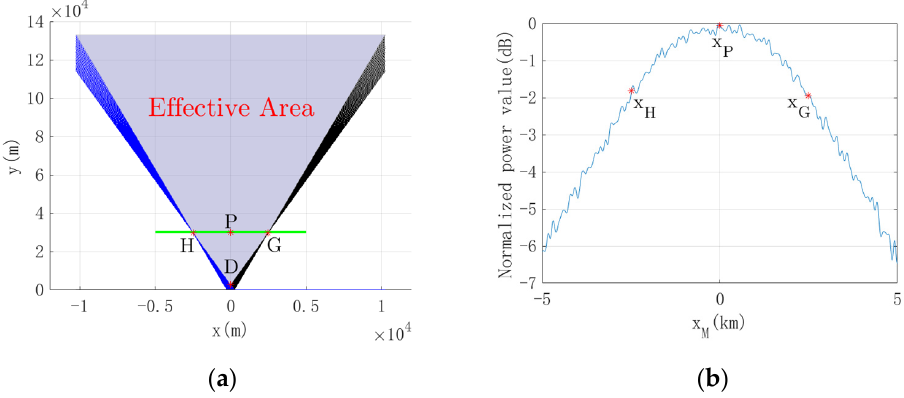
Figure 8. Change of main-lobe power within the effectively compensated area; ( a ) moving radiant source M trajectory; ( b ) variation of main-lobe power value with x M .